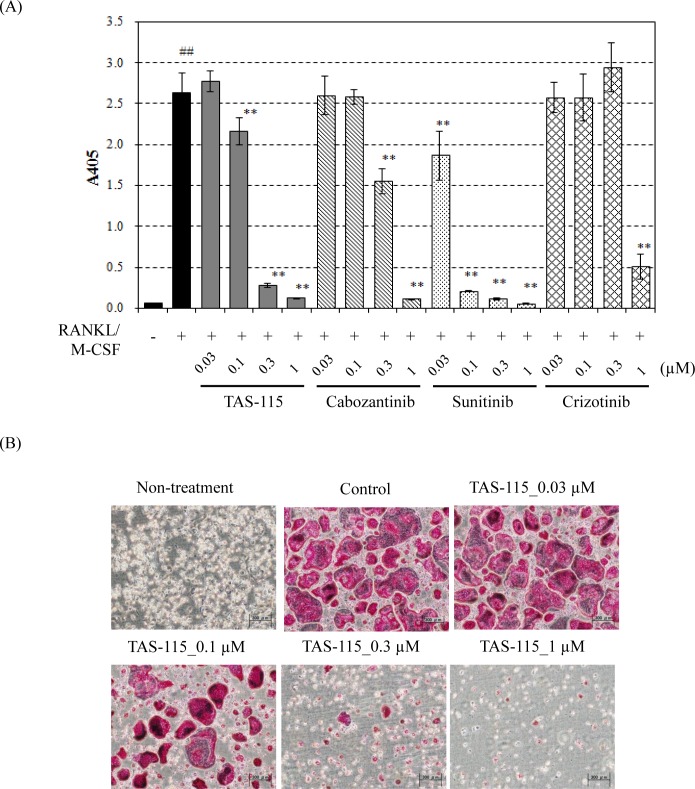
Inhibitory activity of TAS-115 against osteoclast formation and signal transduction in osteoclasts.(A) Effect of TAS-115, cabozantinib, sunitinib, or crizotinib against M-CSF and RANKL induced osteoclast formation. The Y axis indicates absorbance at 405 nm (A405) that reflects TRAP activity in cells, which was used as an indicator of osteoclast formation. Data are expressed as means ± SD (n = 4). ##, p<0.01 in the comparison of the control group (the cultures treated with RANKL and M-CSF) with the non-treated group (the cultures without RANKL and M-CSF treatment) (Student’s t-test). **, p<0.01 in the comparison of the treated group with the control group (Dunnett’s test). (B) Representative photographs of TRAP-positive cells in the non-treated, control and TAS-115 treated cultures. M-CSF dependent bone marrow macrophages (MDBMs) were cultured for 4 days without RANKL, M-CSF or TAS-115 as the non-treated group. MDBMs were maintained in M-CSF and RANKL without TAS-115 for 4 days as the control group. For TAS-115 treatment, MDBMs were maintained in M-CSF, RANKL and the indicated concentration of TAS-115 for 4 days.